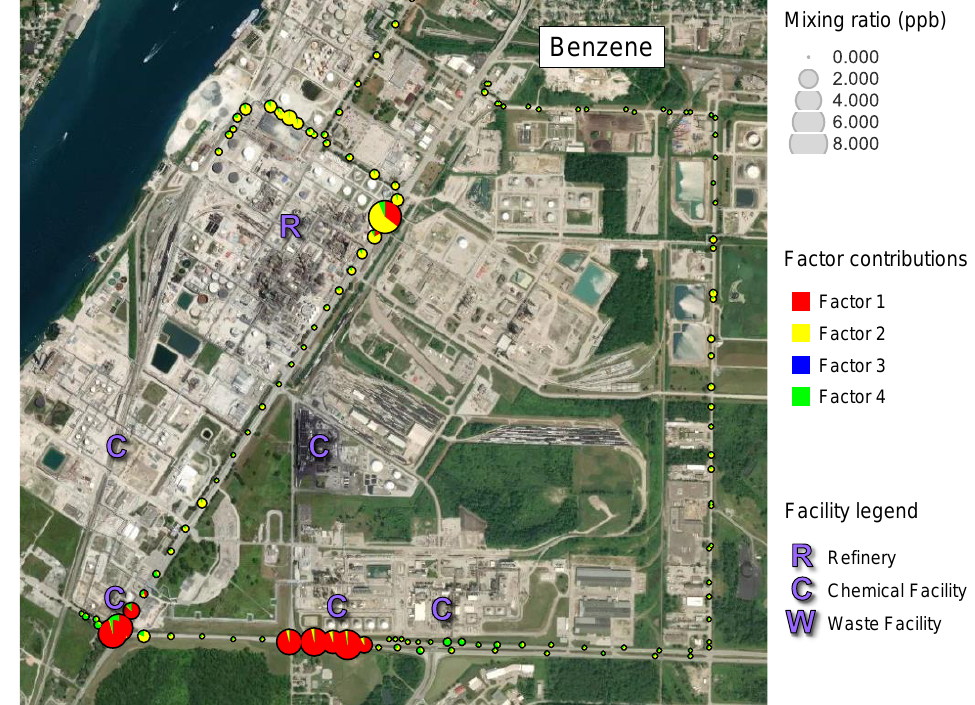
Figure 5. Contributions of each of the four local factors to benzene mixing ratios as a function of measurement location while mobile on 16 June 2020, 14:10 – 14:45. Wind was northerly at the time. The diameter of each pie denotes the benzene mixing ratio and the size of each wedge within each pie represents the relative contribution of each factor for that measurement period.